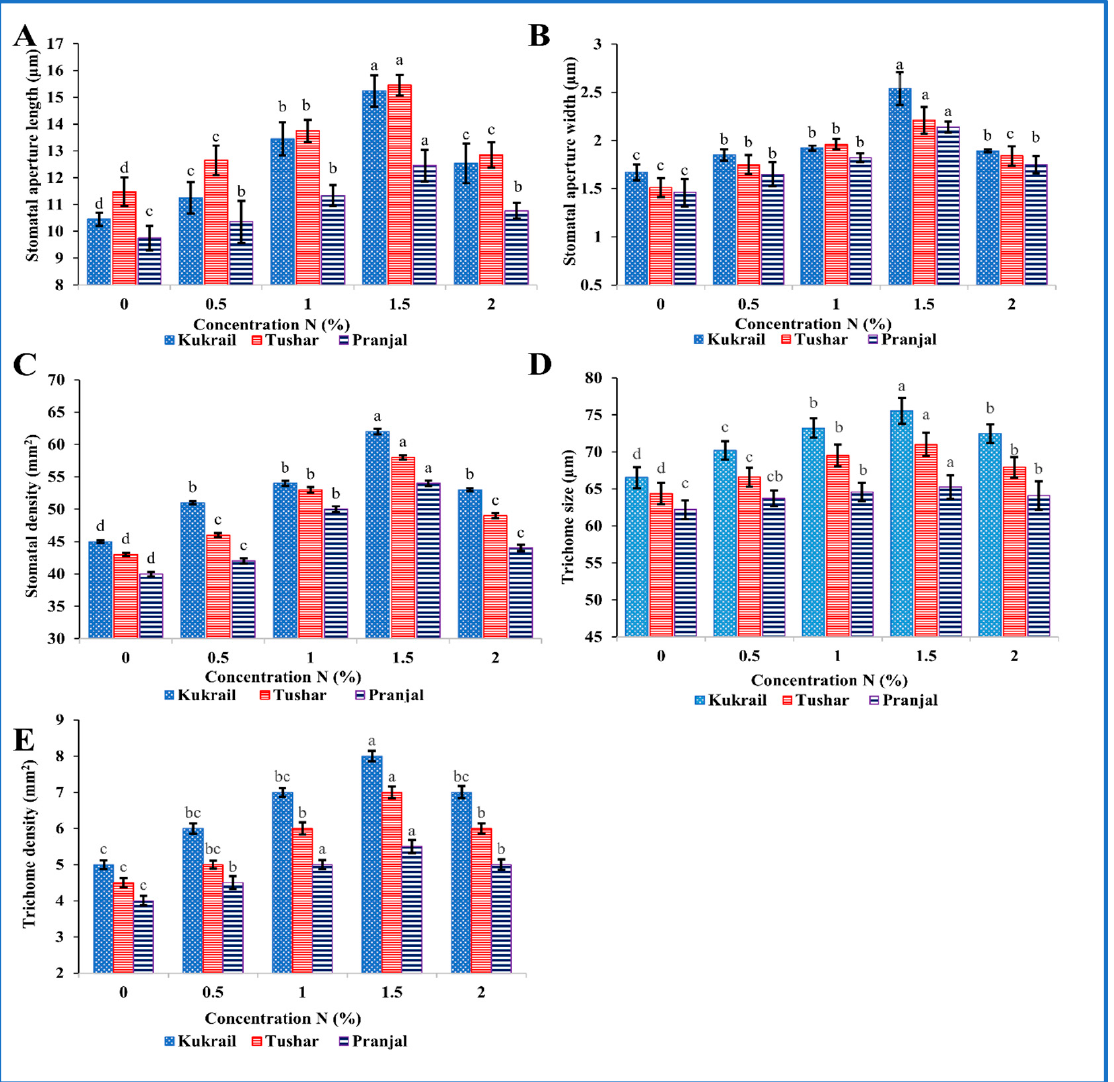
Figure 8. Effect of N on three cultivars: ( A ) Stomatal aperture length, ( B ) Stomatal aperture width, ( C ) Stomatal density, ( D ) Trichome size, ( E ) Trichome density of the three studied peppermint cultivars. Data represent the mean of four replicates ( n = 4) and bars represent their standard error (SE). The letters over bars represent significance at p ≤ 0.05 by Duncan’s Multiple Range Test (DMRT).